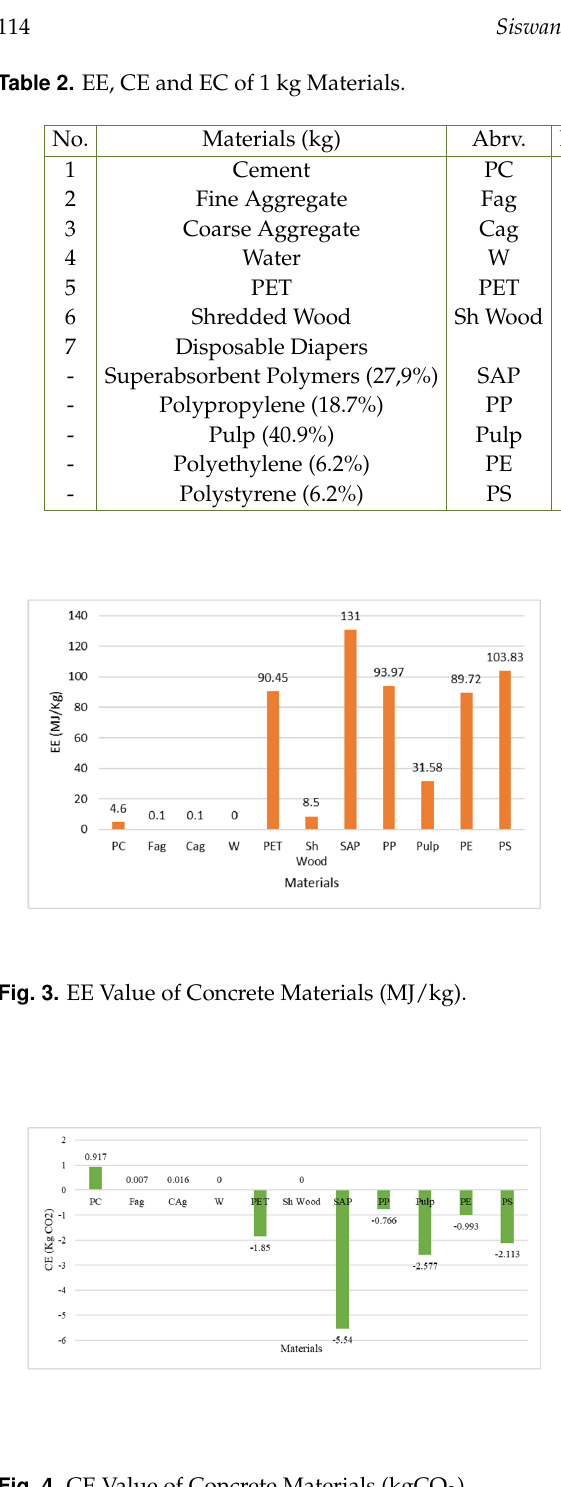
Fig. 4. CE Value of Concrete Materials (kgCO 2 ).